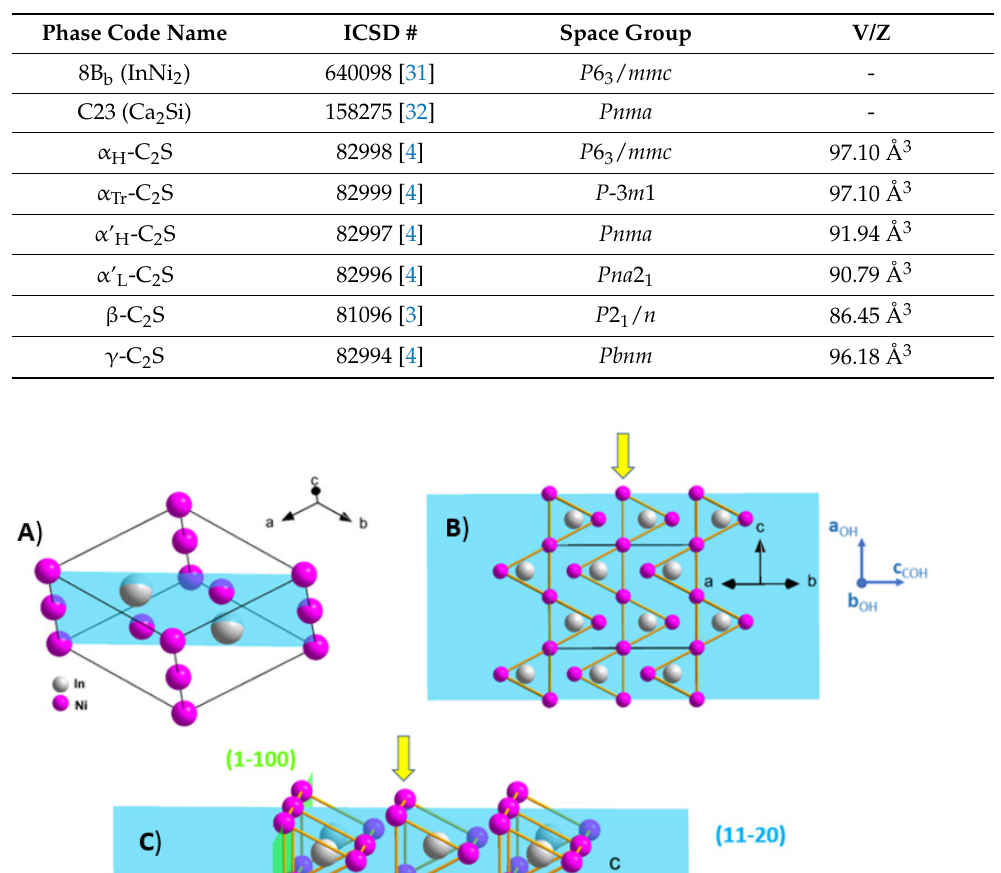
Table 1. Structural information and parameters for the prototype 8B2 and C23 prototype structures and the five polymorphs of belite (Ca 2 SiO 4 ).